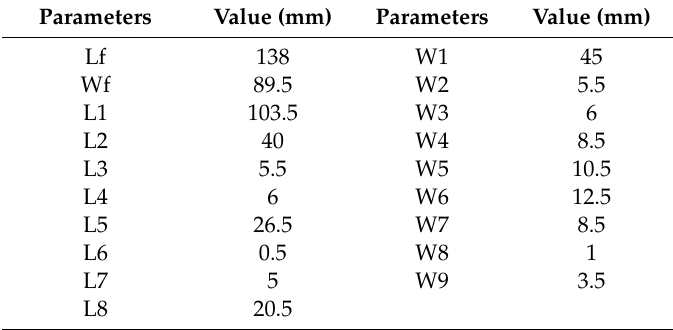
Figure 9. Input impedance of the proposed UHF antenna. Table 1. Design parameters of the proposed UHF antenna.